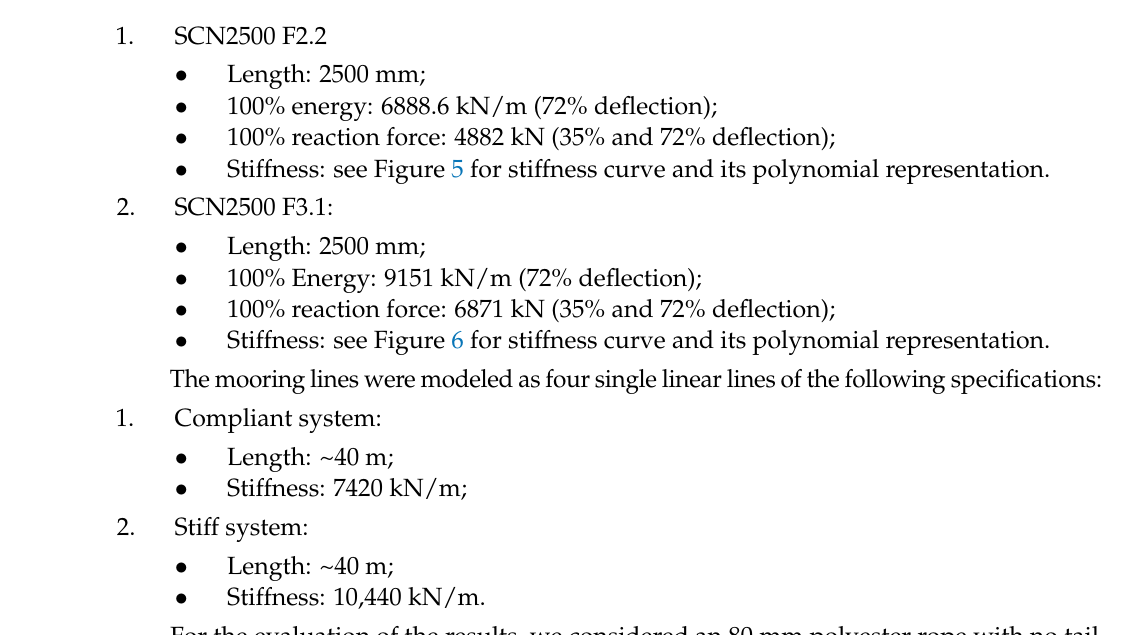
Stiffness: see Figure 6 for stiffness curve and its polynomial